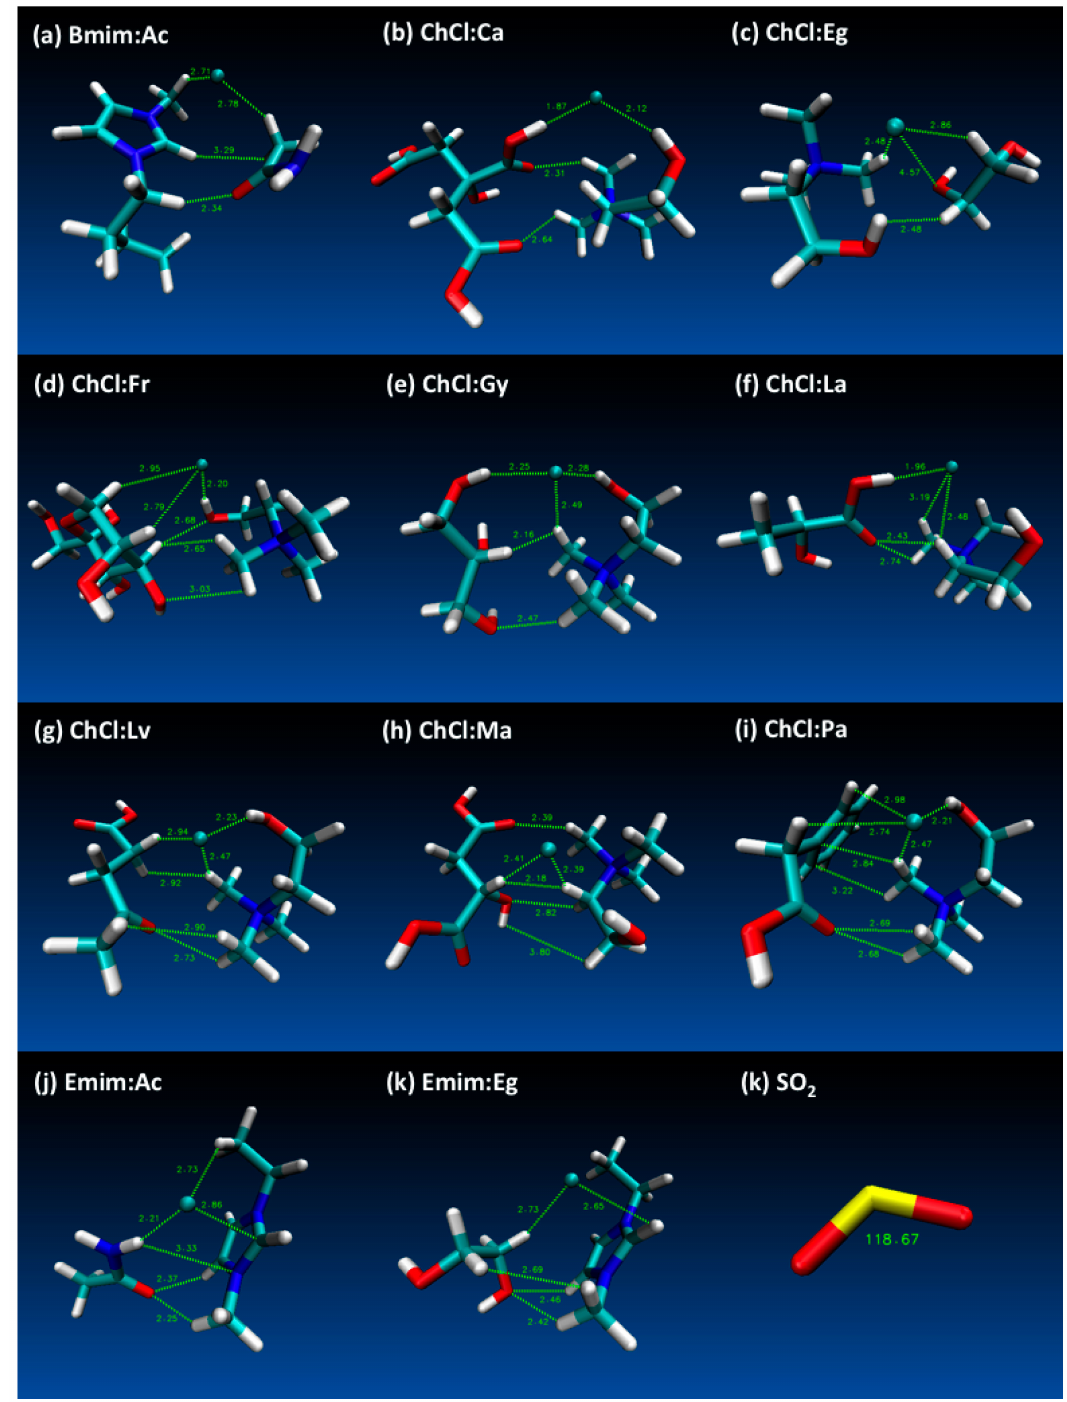
Figure 2. Geometry optimized deep eutectic solvent (DES) structures (and SO 2 ) that are studied in this work (displayed distances are in Å and SO 2 angle is degrees ◦